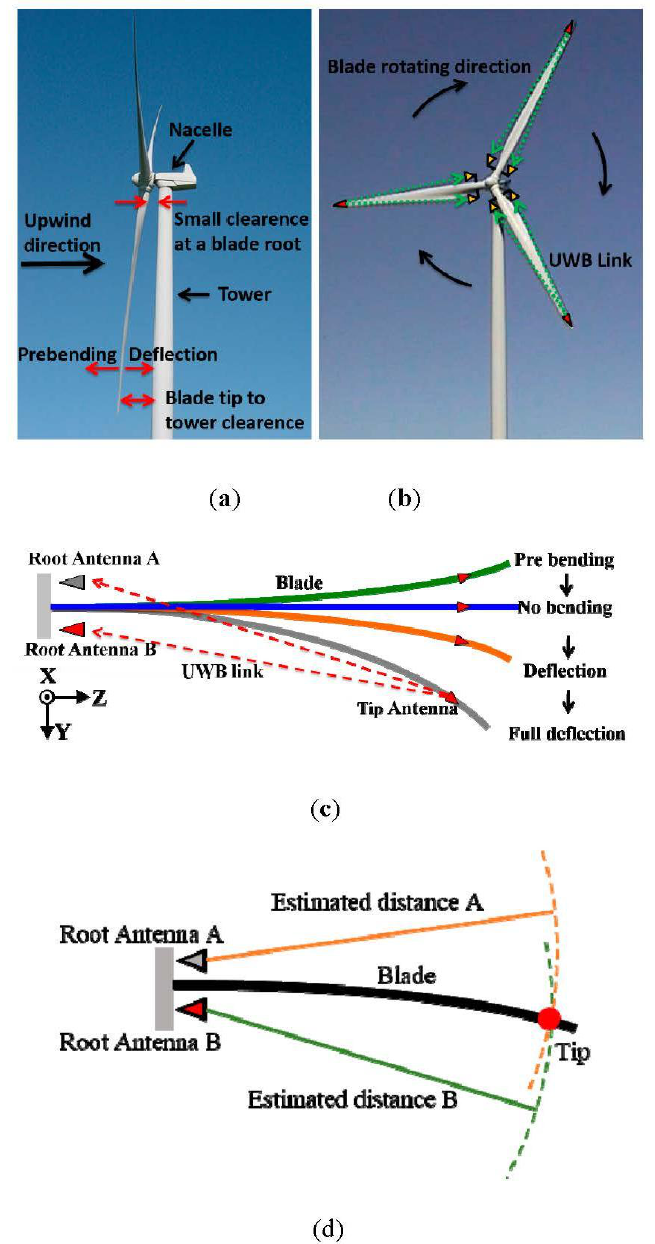
Figure 1. ( a ) The side view of a wind turbine; ( b ) the wind turbine with three UWB blade deflection sensing systems; ( c ) the UWB blade deflection sensing system topology and ( d ) a sketch of